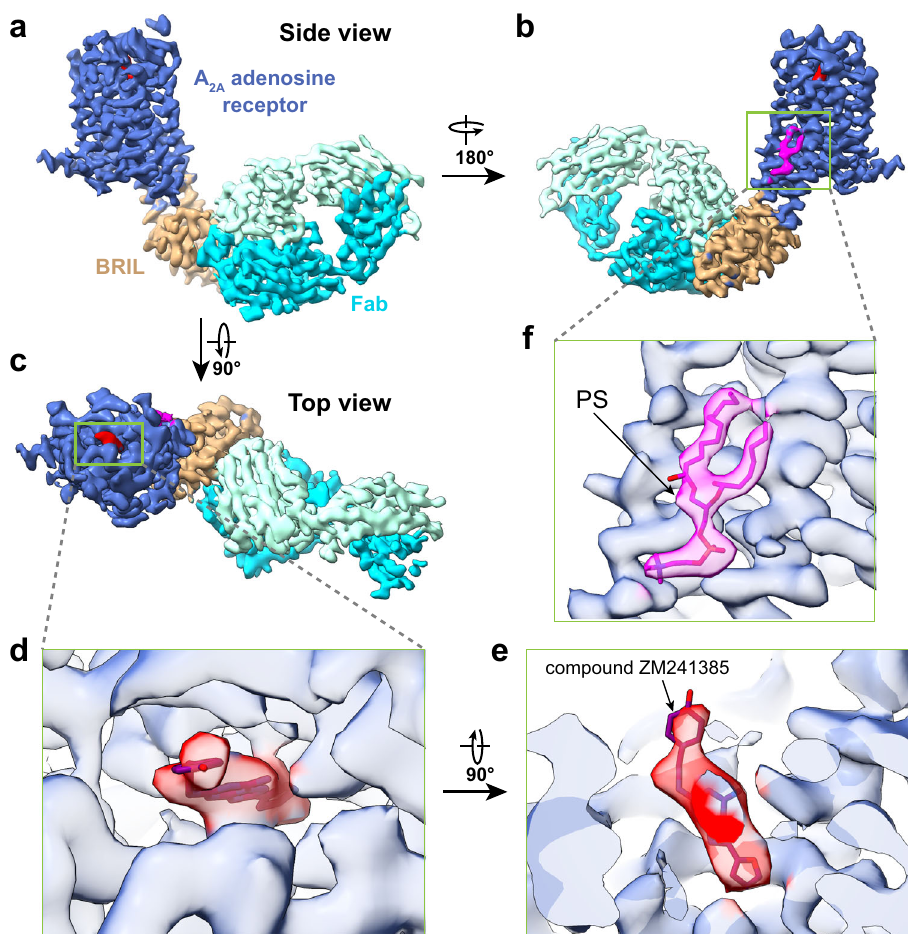
Fig.1|Single-particlecryo-EMstructureofA 2A R-BRIL.a – c Threedifferentviews of cryo-EM density map of A 2A R-BRIL bound with an anti-BRIL Fab. d , e Close-up